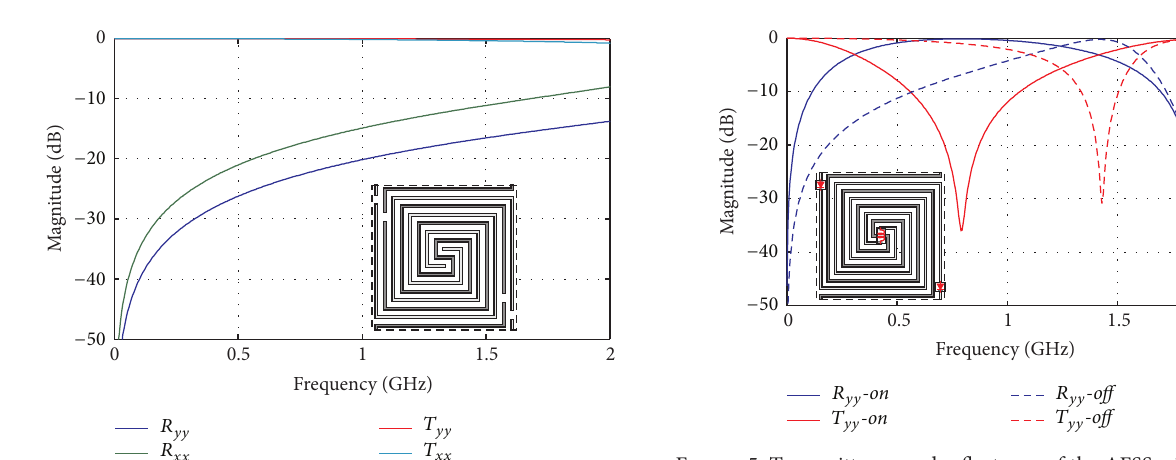
Figure 5: Transmittance and reflectance of the AFSS with the unit cell of Figure 1 at normal incidence of a y -polarized wave when pin diodeswitchesareinthe on (solidlines)and off